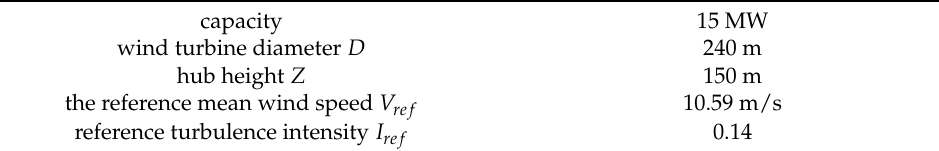
Table 2. 15 WM wind turbine parameters.